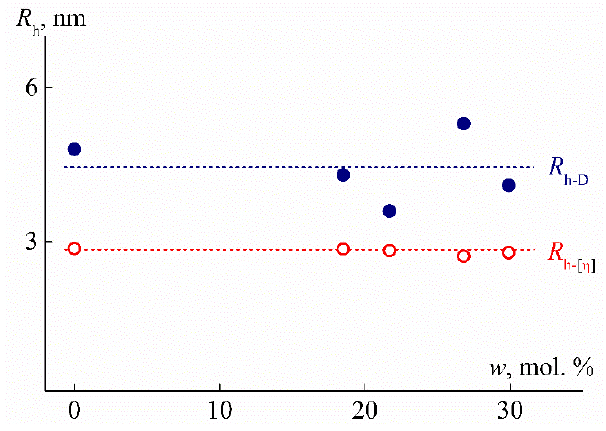
Figure 9. Dependencies of translation hydrodynamic radius R h-D and viscosity hydrodynamic radius R h- on cross-linker content w for the studied PEI-0 and PEI-n.